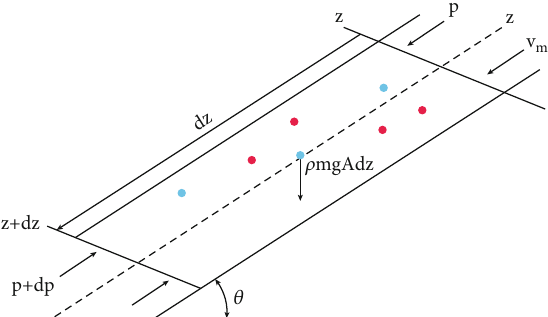
Figure 2: Micro element diagram of one-dimensional gas-liquid two-phase fl